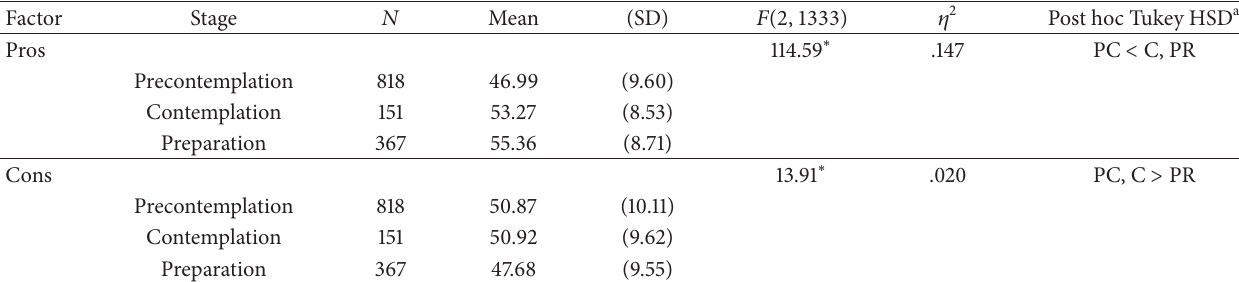
Table 4: Standardized 𝑇 -scores (SD) for Decisional Balance by stage of change ( 𝑁 =